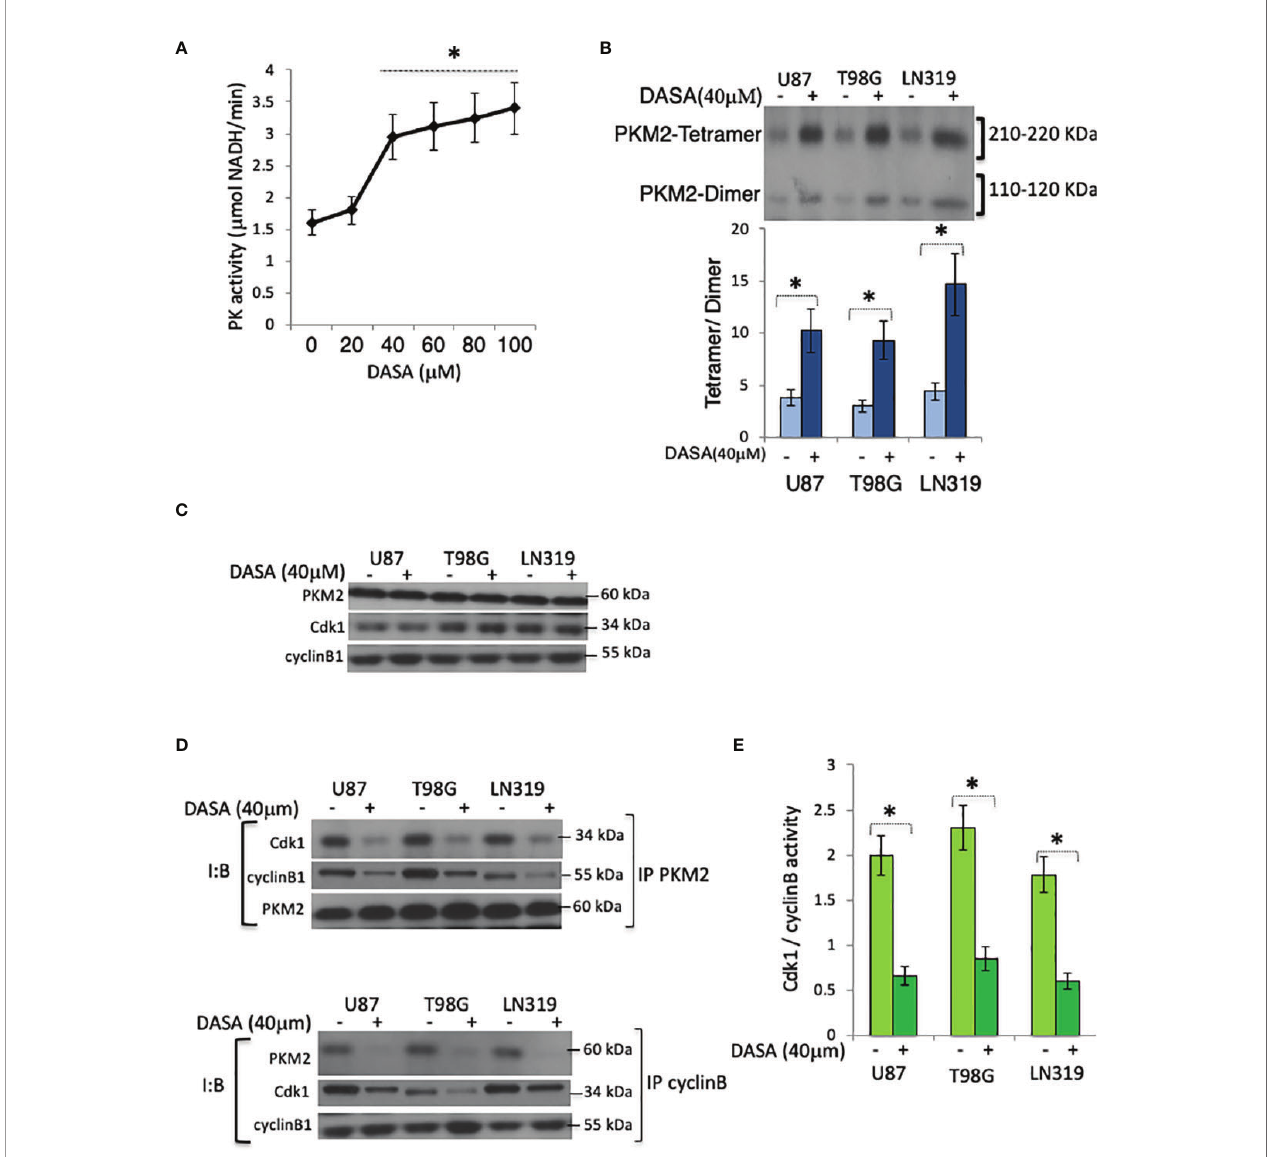
FIGURE 3 | Pharmacologic activation of PKM2 suppresses Cdk1-cyclin B complex levels. (A) PK activity in U87 cells exposed to DASA-58 (0-100 m M, 3 hrs) as measured by an in vitro PK assay. (B) Levels of tetrameric and dimeric PKM2 in chemically cross-linked lysates of U87, T98G, or LN319 cells10 hrs following release from serum deprivation-induced arrest and incubated with vehicle (DMSO) (-) or DASA-58 (40 m M) 3hrs before harvest. The lower panel is the densitometric analysis of the data in the upper panel displayed as the tetramer/dimer ratio, (C) Levels of PKM2, Cdk1, and cyclin B in vehicle(DMSO)(-) or DASA-58-treated (40 m M, 3 hrs) U87, T98G, or LN319 cells from panel (B) (D) Levels of Cdk1, cyclin B1 and PKM2, in whole cell PKM2 (top) or cyclin B (bottom) immunoprecipitates from cells 10 hrs after release from serum deprivation-induced arrest and which were exposed to vehicle (DMSO) (-) or DASA-treated (40 m M) for the last three hrs of the study. (E) Cdk1-cyclin B activity in lysates from panel (B) I:B, Immuno Blot; IP, immunoprecipitate. *p <.05,